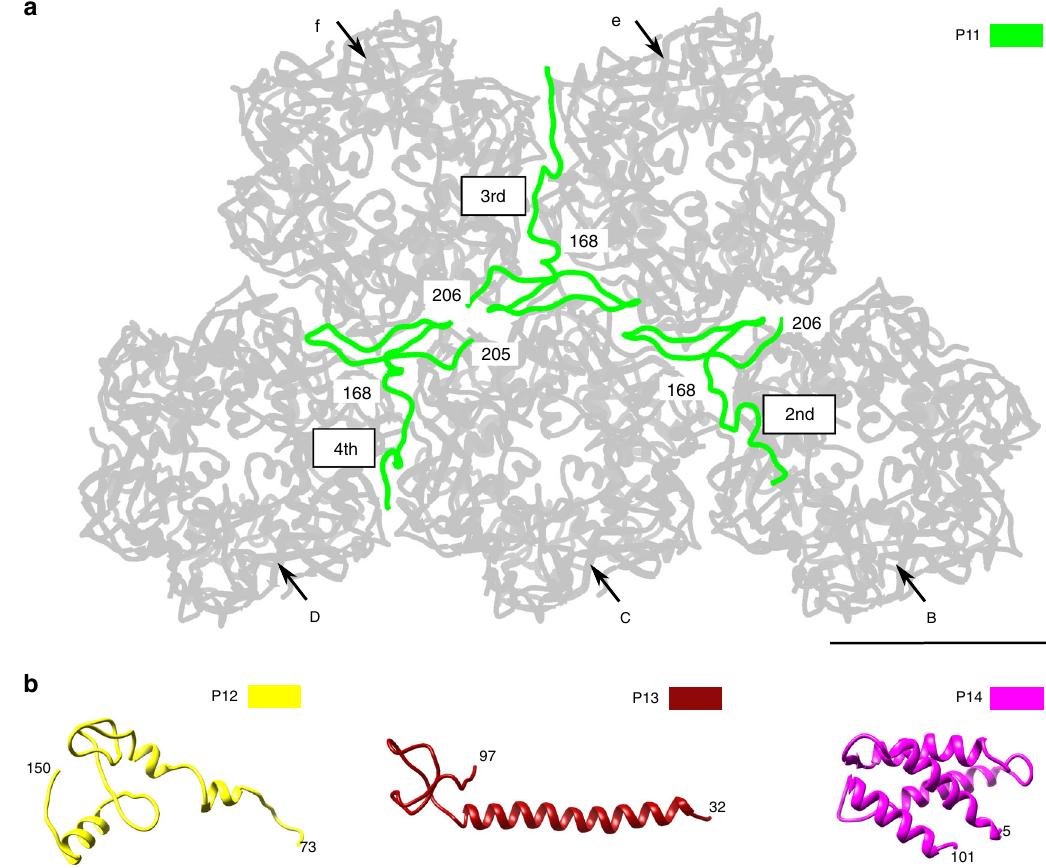
Fig. 5 Structures of minor capsid proteins P11, P12, P13, and P14. These proteins bind together neighboring symmetrons and/or have potential membrane association functions. All the structures are shown as ribbon diagrams. a The second, third, and fourth P11 molecule within an icosahedral asymmetric unit (see Fig. 1c) and their neighboring capsomers (gray). All the capsomers are labeled as in Fig. 1c. b Minor capsid proteins P12, P13, and P14. Scale bars, 50